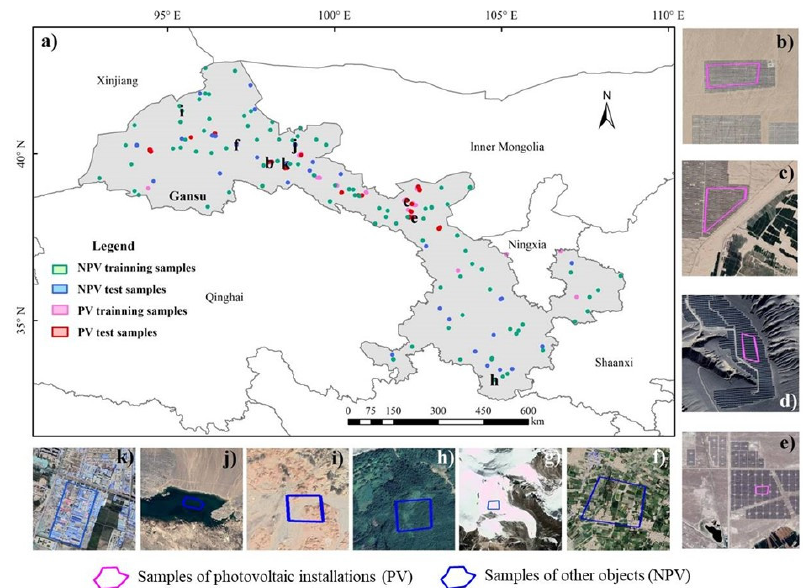
Figure 3. ( a ) The distribution of training and test samples for PV and NPV objects in Gansu Province, ( b – k ) are examples of the PV and NPV samples. Remote Sens. 2022 , 14 , x FOR PEER REVIEW